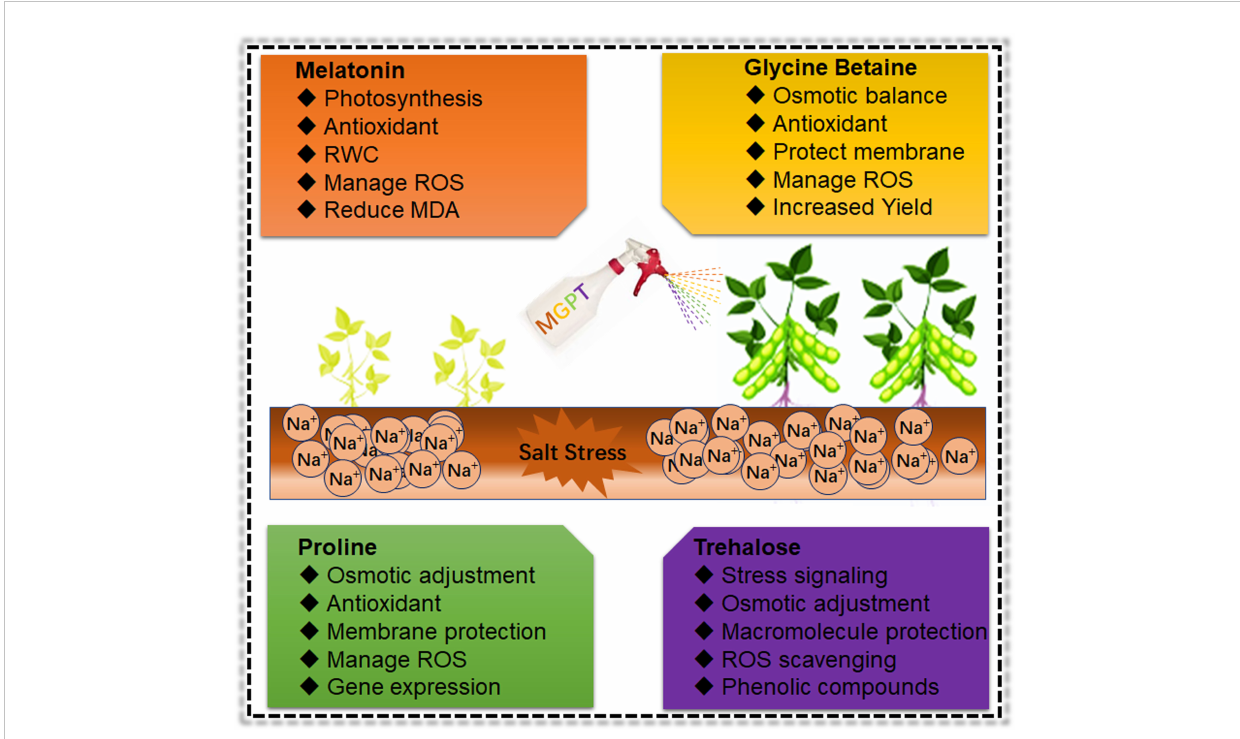
FIGURE 5 Role of osmoprotectants in ameliorating the Soybean salt stress effects Exogenous application of different biochemical increased the growth and development mainly through enhancement of antioxidant activity, ROS scavenging and protection of cellular structure and membranes under salt stress conditions in Soybean. However, these are short-term approaches to mitigate the salt impacts on Soybean. Therefore, it is necessary to use more advanced biotechnological and breeding approaches to develop salt resilient Soybean